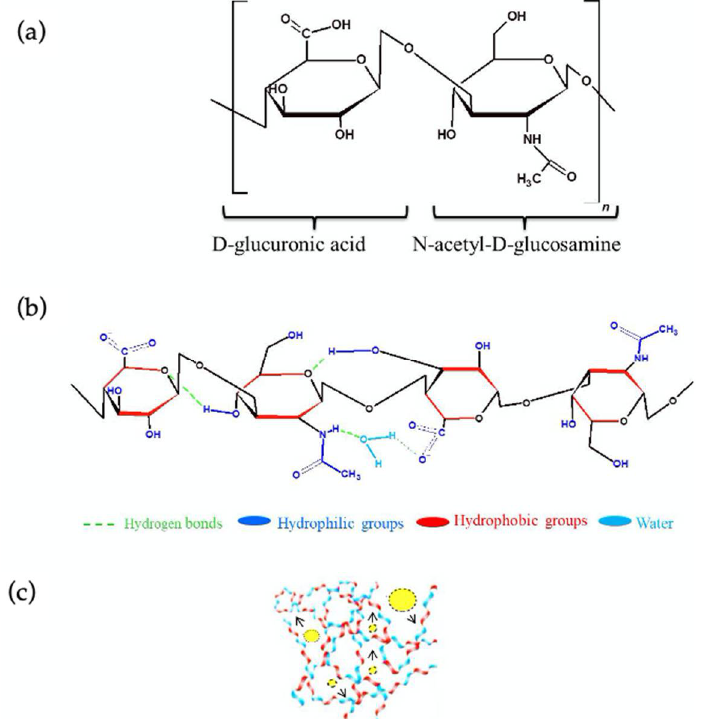
Figure 1. ( a ) Chemical structure of hyaluronic acid (HA). ( b ) HA tetrasaccharide unit with hydrophilic functional groups (in blue), hydrophobic moieties (in red), and hydrogen bonds (dashed lines in green). ( c ) Random coil structure of HA (blue: hydrophilic; red: hydrophobic) with the effect of diffusion (free molecules with arrows).